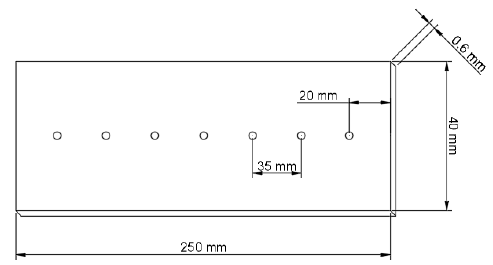
Figure 1. Sample geometry and measuring spots for WAXS.